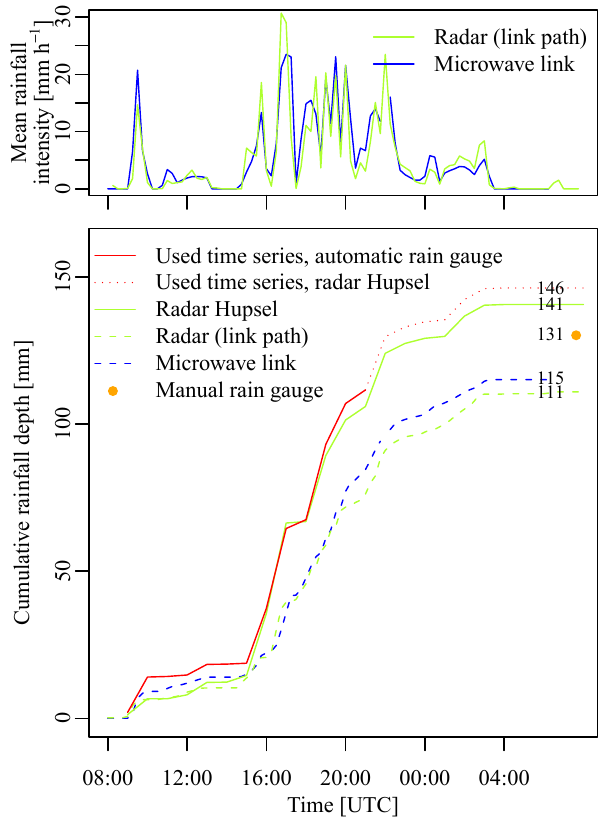
Fig. 6. Top: temporal dynamics of rainfall intensity. Blue: mi- crowave link. Green: path-averaged gauge-adjusted radar data. The temporal resolution is 15min. Rainfall intensities from radar data are shifted 15min forward in time, because it takes some time for the droplets measured aloft by the radar to reach the level of the microwave link. Bottom: cumulative rainfall depths from 26 Au- gust, 08:00UTC to 27 August, 08:00UTC. Solid red: automatic rain gauge. Dotted red: gauge-adjusted radar data at the location of the automatic rain gauge, which were used to fill gaps of the auto- matic rain gauge data. Solid green: gauge-adjusted radar data at the location of the automatic rain gauge. Dashed green: gauge-adjusted radar data averaged over the microwave link path. Dashed blue: microwave link. One orange point: manual rain